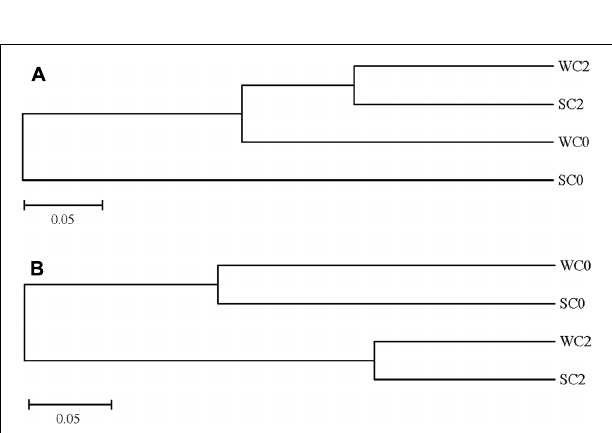
FIGURE 5 | UPGMA clustering of AOA (A) and AOB (B) community